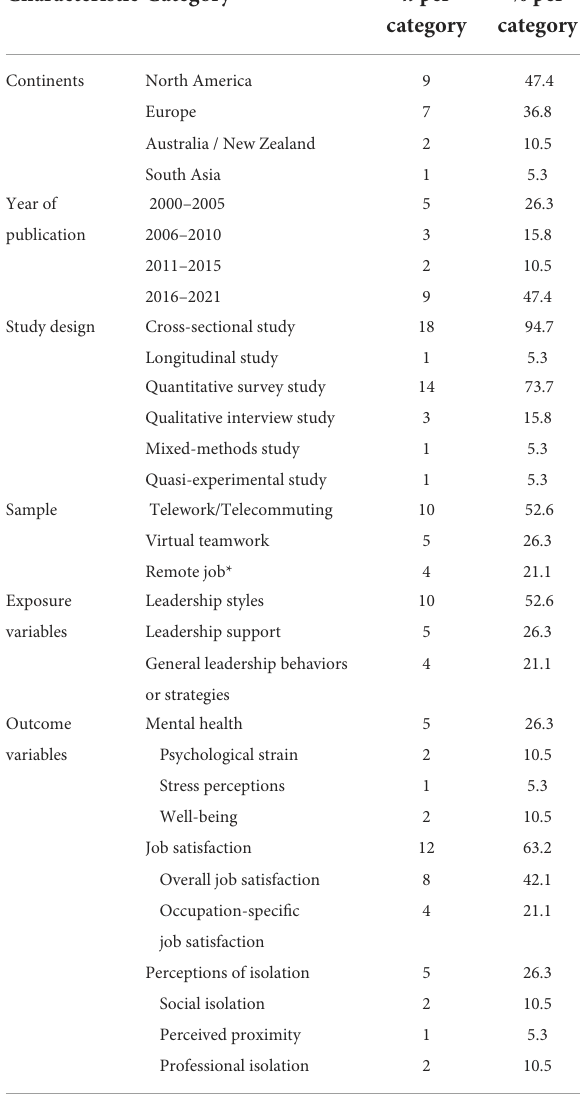
TABLE 2 Characteristics of included studies ( n =